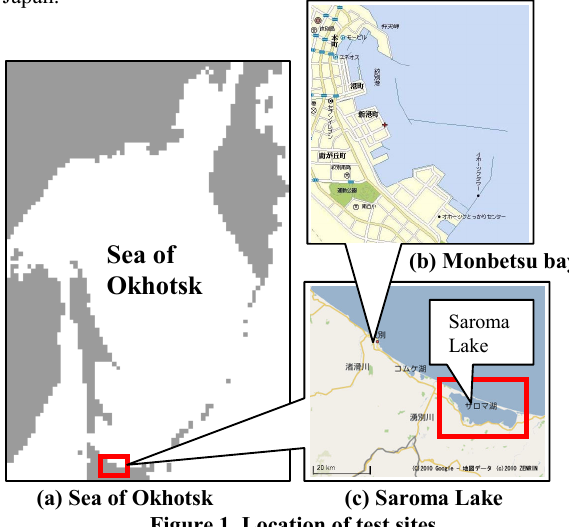
Figure 1. Location of test